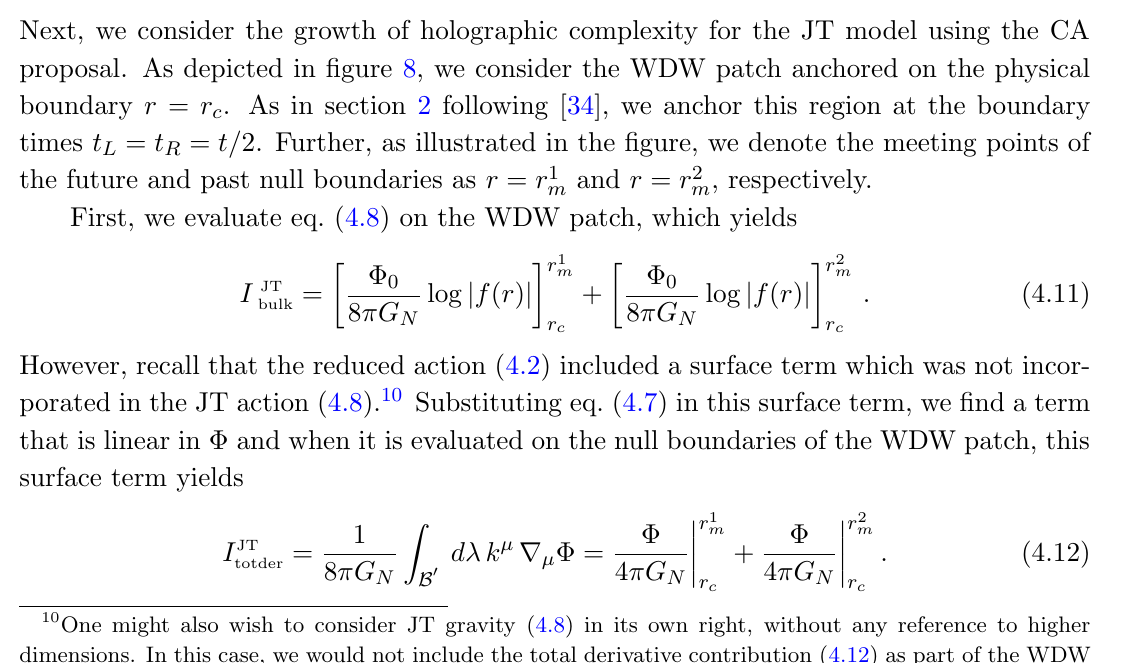
= (cid:6) (cid:22) (cid:6)